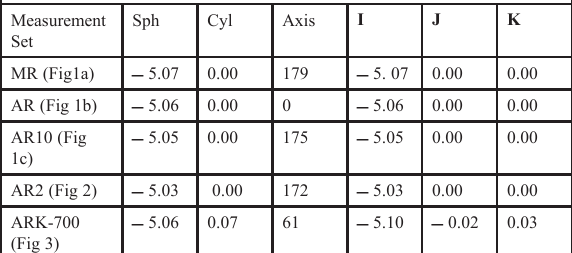
Table 1. Means of 50 measurements are shown. MR, AR, AR10, AR2 and Ark-700 represent the data collected as discussed in the text and as shown in Figures 1a, 1b, 1c, 2 and 3 respectively. Means have been rounded to two decimal places resulting in many of the components being shown as zero. Means are represented in conventional as well as component notation.